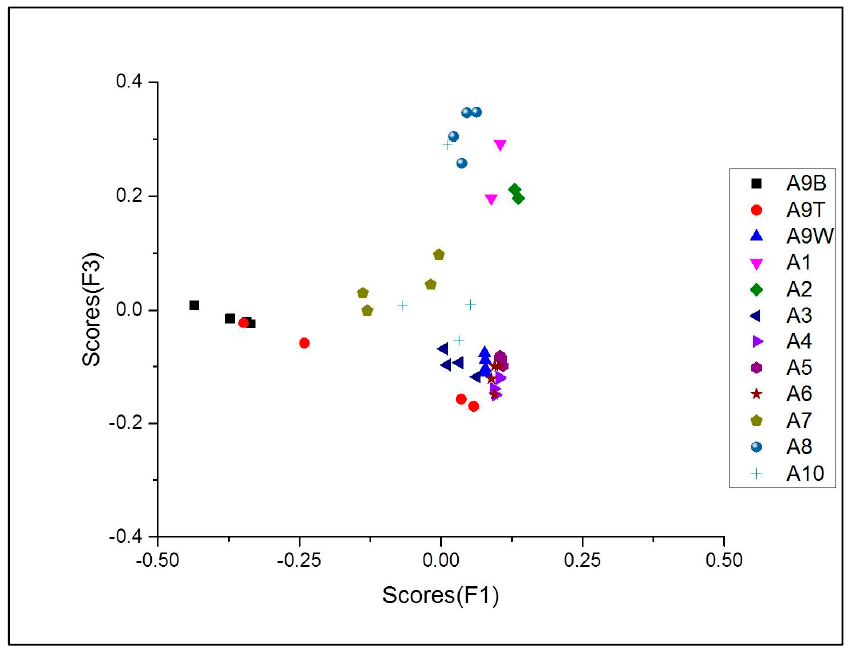
Figure 13. PCA results of the ten astronomical